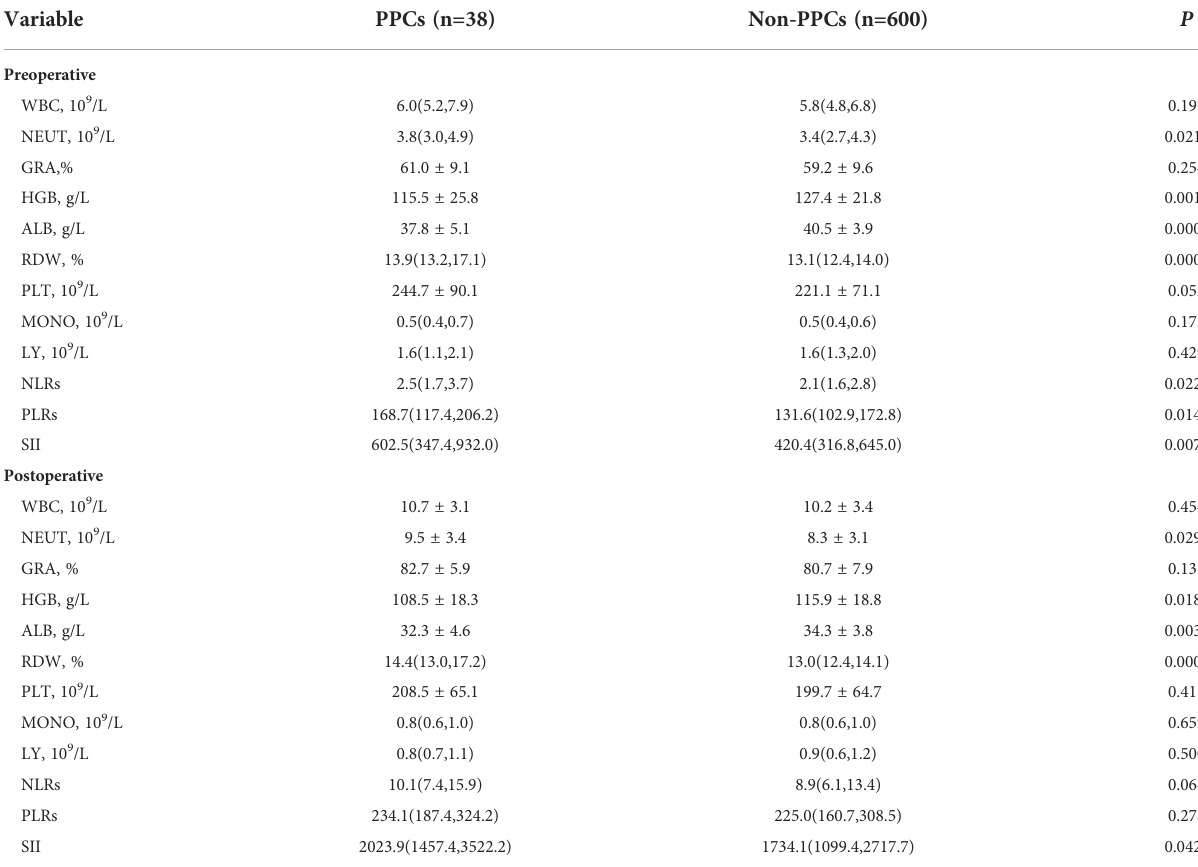
TABLE 4 Results of preoperative and postoperative blood tests in patients.